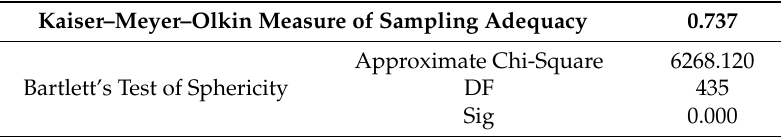
Table 7. Kaiser–Meyer–Olkin (KMO) and Bartlett’s